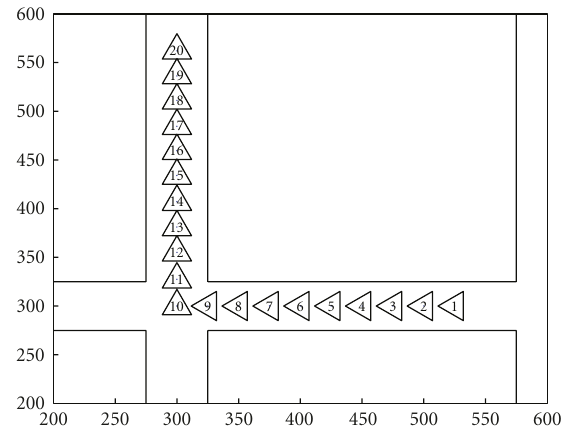
Figure 2: Example of attacker mobility path.